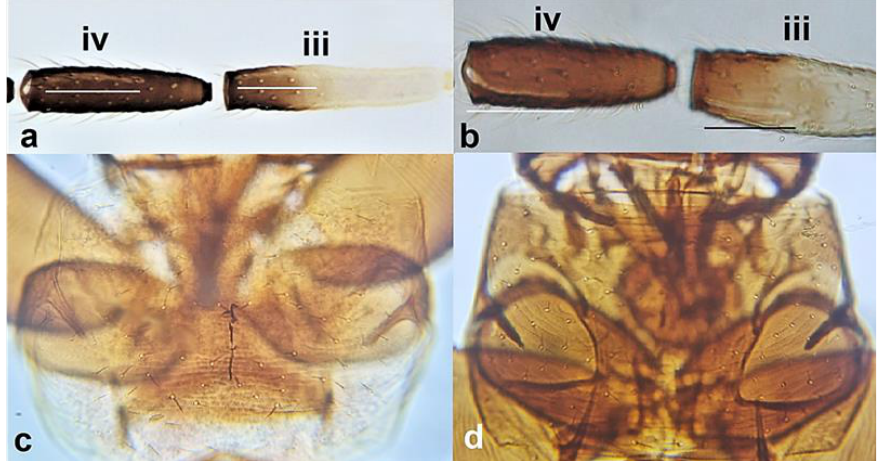
Figure 9. Antennal segments III and IV ( a , b ): ( a ) sensoria about one third the length of segment in III, two thirds the length of segment in IV; ( b ) sensoria about half the length of segment in both III and IV; pronotum ( c , d ): ( c ) pale; ( d ) dark.